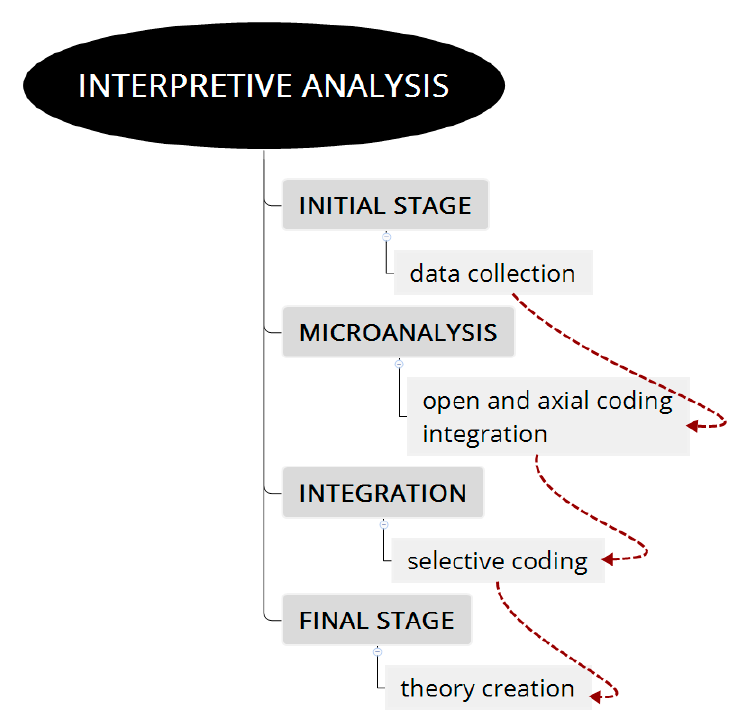
Figure 3. Diagram of the GT analysis process. Source: Own elaboration.